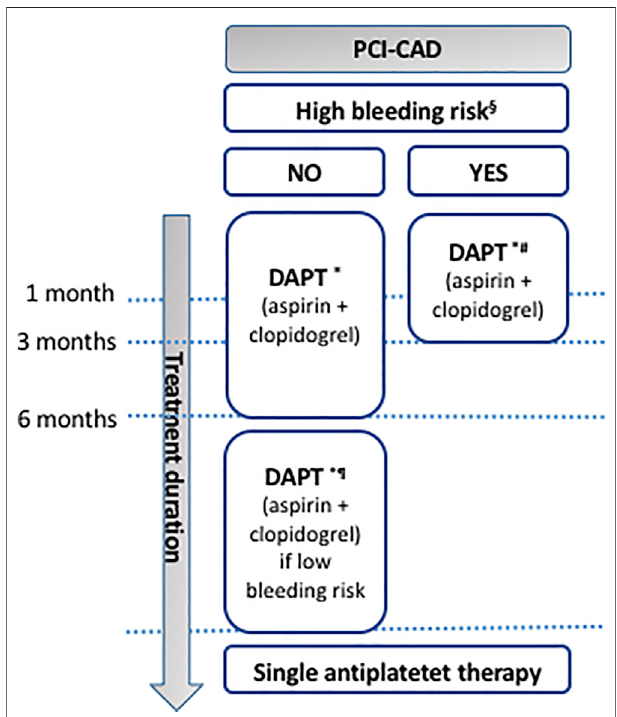
FIGURE 4 | Antiplatelet therapy in CAD patients undergoing PCI. § in case of history of prior bleeding, oral anticoagulant therapy, female sex, advanced age, low body weight, chronic kidney disease, diabetes mellitus, anemia, chronic steroid or nonsteroidal anti-in fl ammatory drugs (NSAID) therapy (American guidelines); in case of need for oral anticoagulant drugs in addition to DAPT, advanced age (older than 75 years), frailty, anemia with hemoglobin < 110 g/L, chronic renal failure (creatinine clearance < 40 ml/min), low body weight ( < 60 kg), hospitalization for bleeding within past